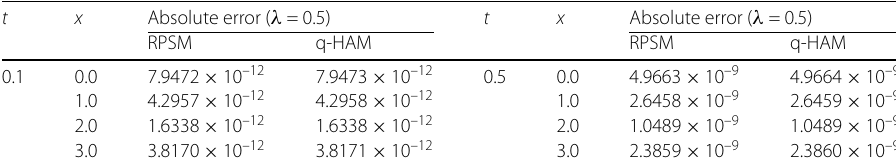
Table 1 Case I Comparison ( U (3) ): RPSM, q-HAM with the exact solution